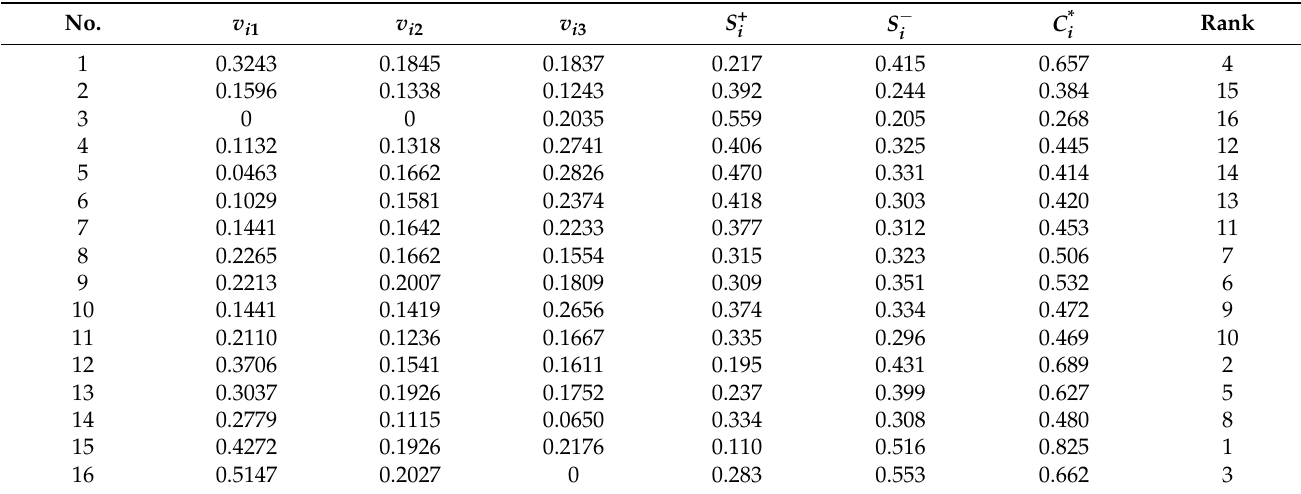
, and their closeness coefficient to the ideal , S − i i